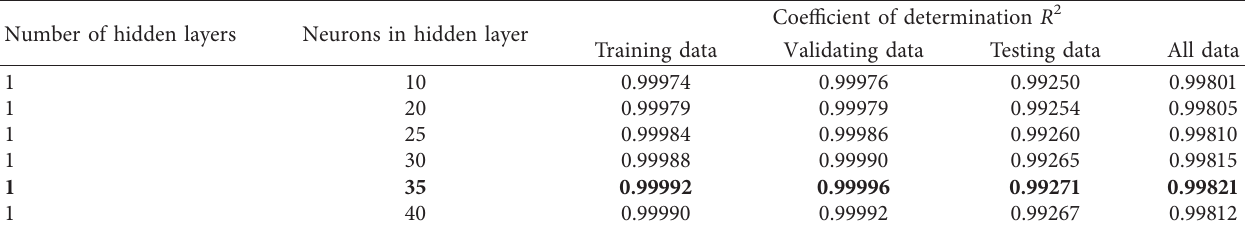
Table 5: Determination coefficient R 2 for different learning algorithms to predict deflection for Scheme B. Number of hidden